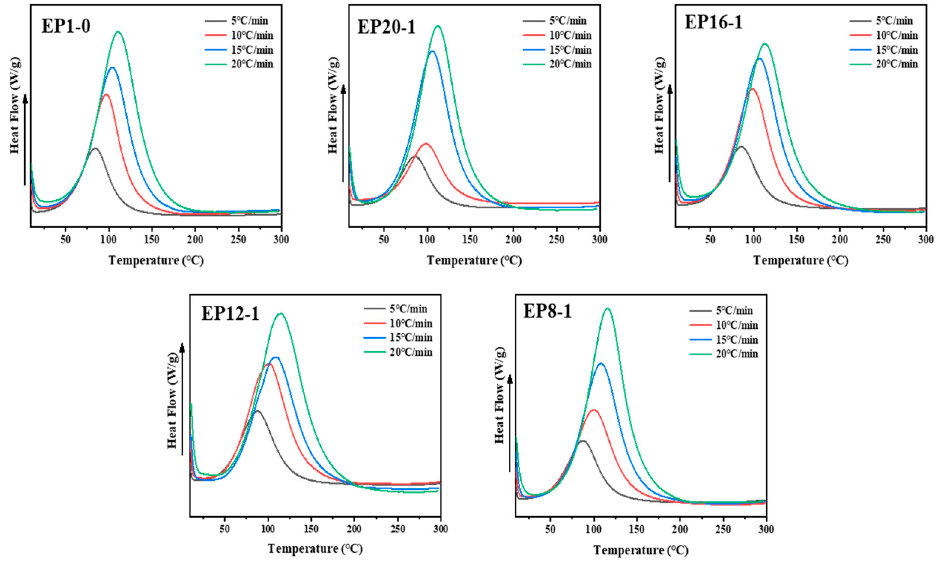
Figure 2. The DSC curves of EPx systems under four different heating rates.